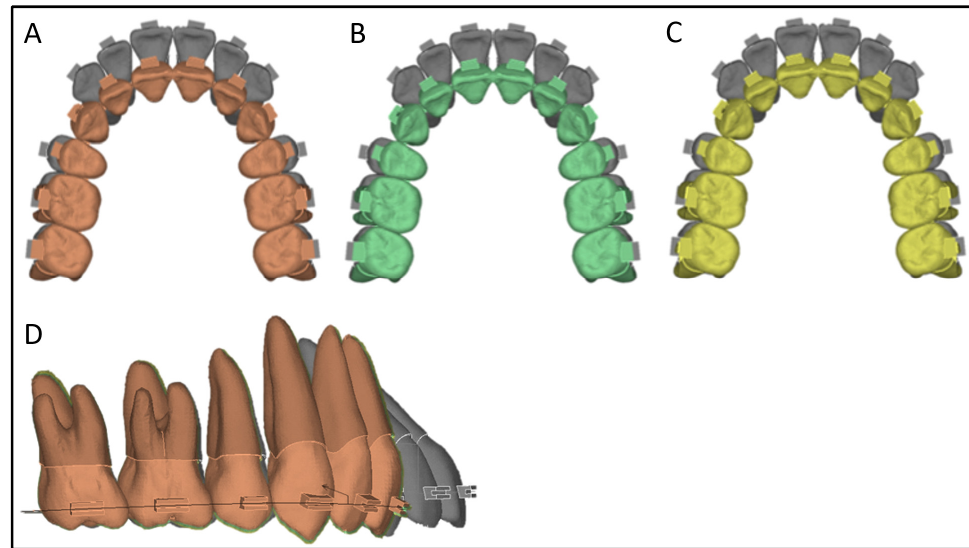
Figure 4. ( A ) Occlusal view of LOMS1 (Orange) after space closing; ( B ) Occlusal view of LOMS2 (Green) after space closing; ( C ) Occlusal view of LOMS3 (Yellow) after space closing; ( D ) Overlap of lateral view at LOMS. Gray-colored teeth, teeth before movement.